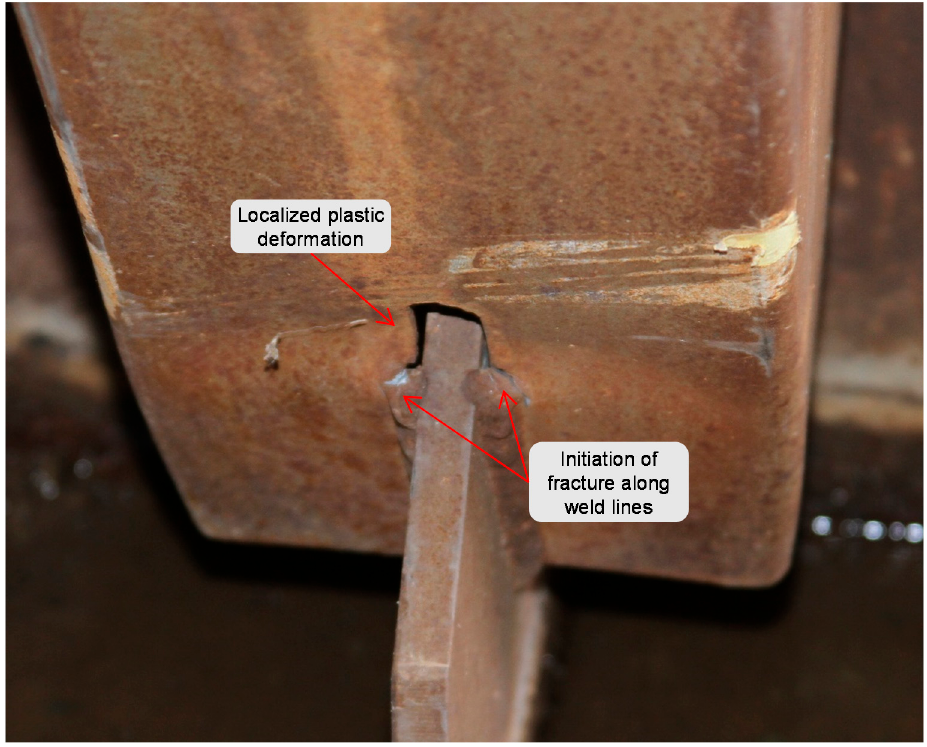
Figure 19. Magnified view of Figure 18b.